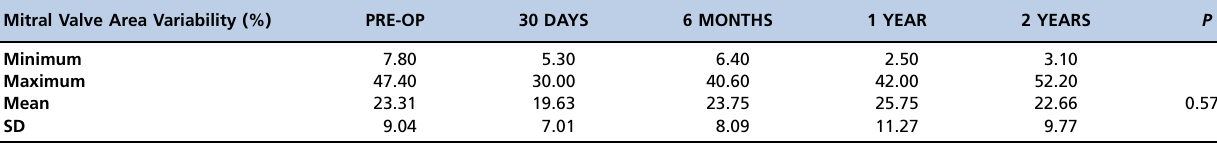
Table 3 - Measurements of variability of mitral valve area during the periods of the study. Mitral Valve Area Variability